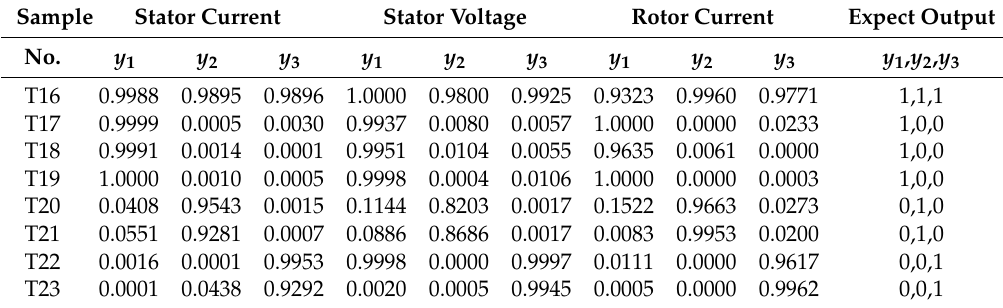
Table 3. The output results of the test sample.